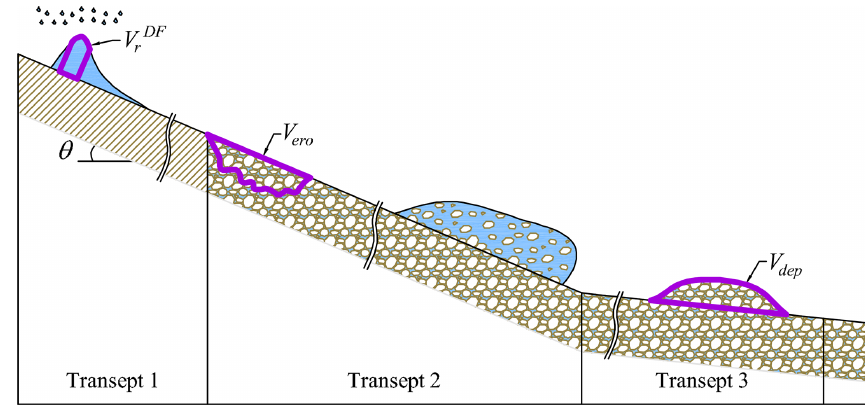
Figure 1. Conceptual Lagrangian volumetric description of the debris-flow dynamic from Rosatti et al. (2019). The scheme is divided into three transepts: transept 1 is characterised by the run-off formation; the bed material erosion and the achievement of equilibrium conditions occur in transept 2; transept 3 is characterised by the deposition of sediments with water entrapment. V DF r is the rain volume pertaining to the debris flow, V ero is the bed volume variation related to the erosion, V dep is the deposited volume occupied by the sediments and θ = arctan (i f ) is the inclination angle of the bed with respect to a reference horizontal